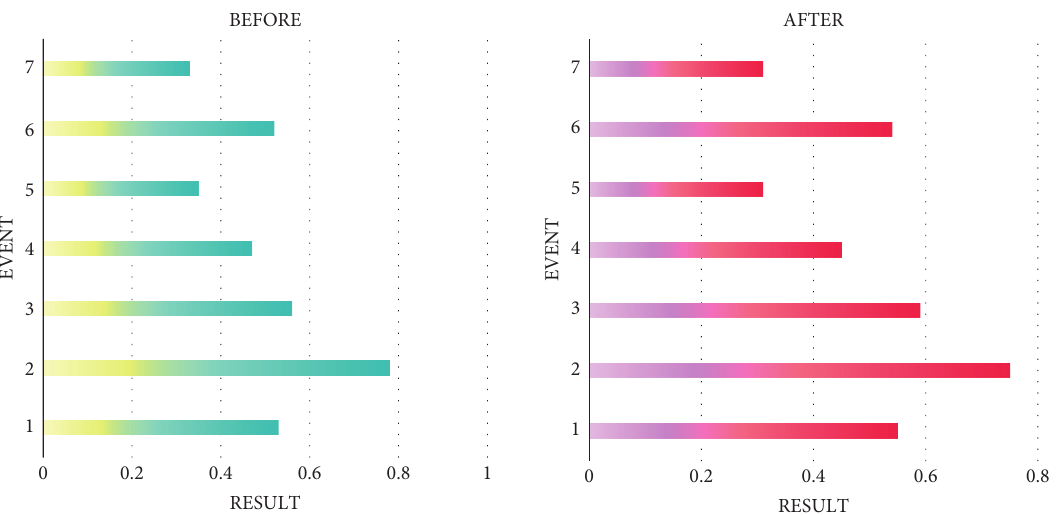
Figure 7: Comprehensive event data before and after processing.